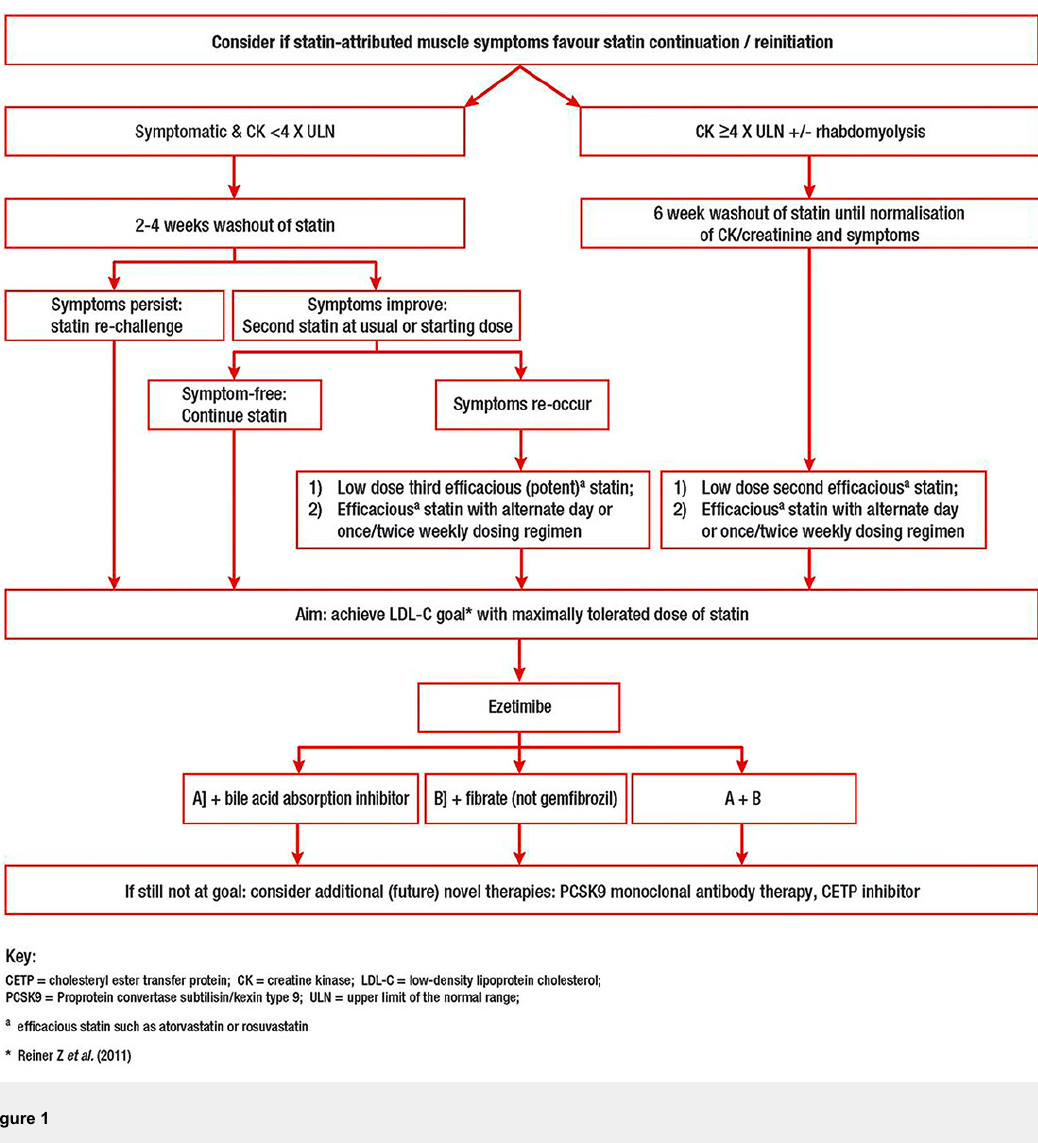
Proposed algorithm for management of patients with statin-associated muscle symptoms. Adapted with permission from [5]. CETP = cholesteryl ester transfer protein; CK = creatine kinase; LDL-C = low-density lipoprotein cholesterol; PCSK9 = proprotein convertase subtilisin/kexin type 9; ULN = upper limit of the normal range a efficacious stain such as atorvastatin or